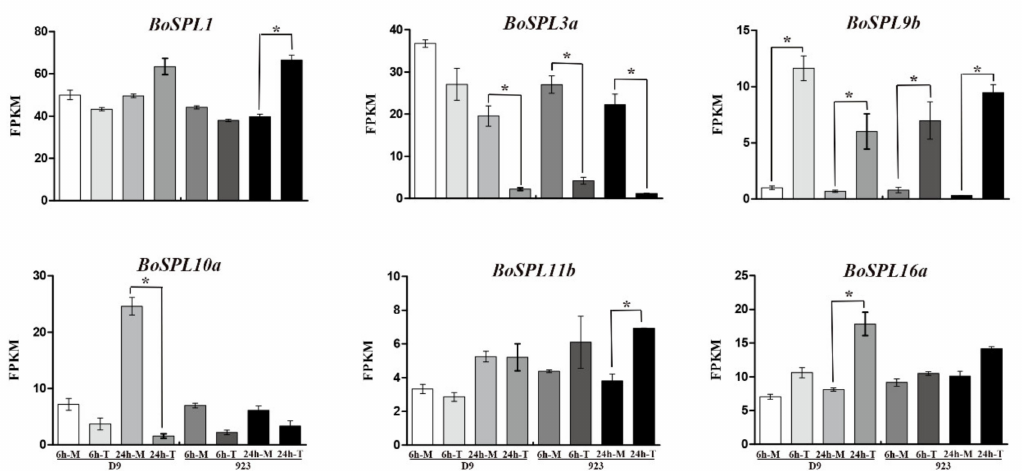
Figure 7. Expression profiles of six BoSPL genes under chilling stress. * indicates that the p -value was less than 0.05. Expression patterns of the thirty-two BoSPL genes under chilling stress are in Supplementary Figure